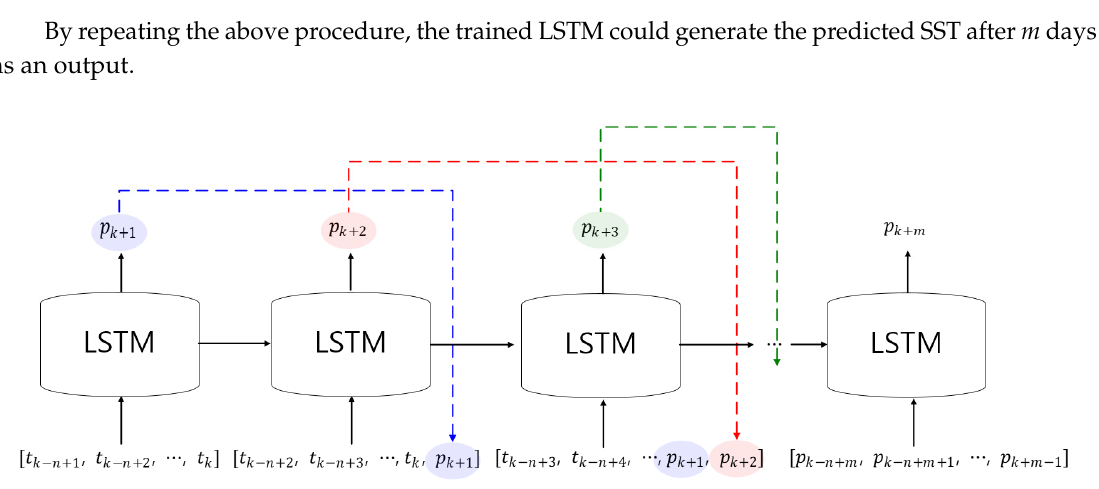
Figure 6. Schematic diagrams for SST prediction after m days using the trained LSTM model.